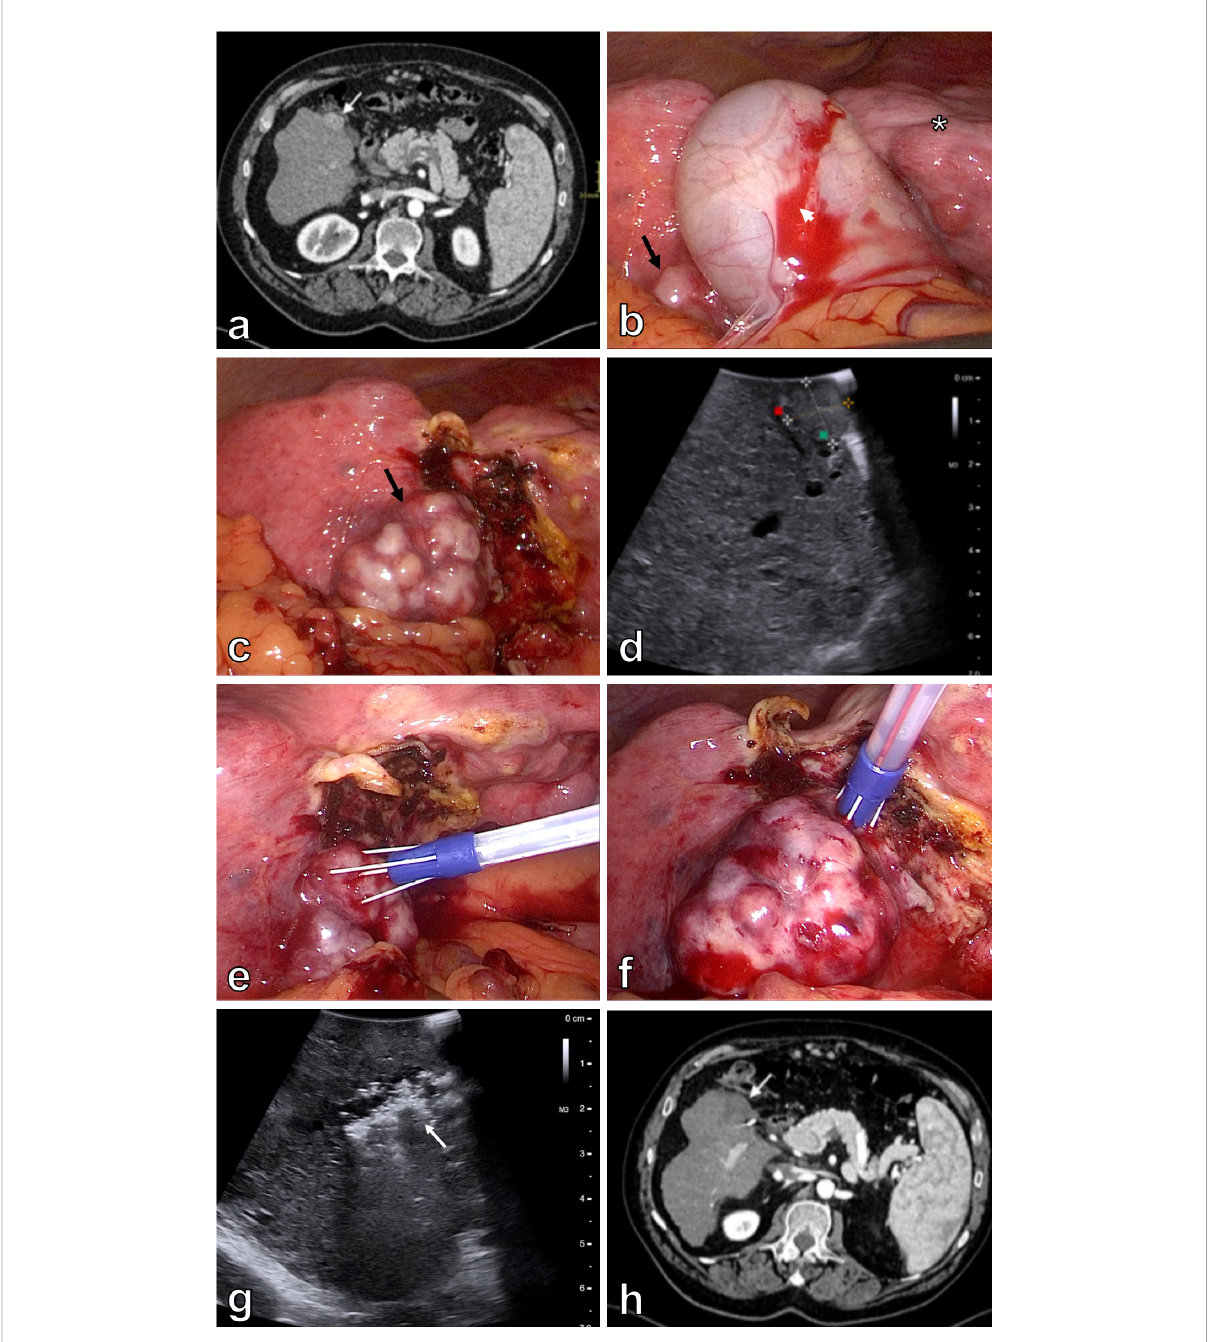
FIGURE 1 Patient 1. Initial contrast enhanced abdominal CT demonstrates a 12 x 18 mm hypervascular lesion in segment V of the cirrhotic liver (white arrow) (A) . Laparoscopy shows macronodular liver cirrhosis (asterisk) with an exulcerated tumor in segment V (black arrow). The majority of the tumor is covered with gallbladder (white arrowhead) (B) . Optimal exposure of the tumor (black arrow) is achieved after cholecystectomy (C) . Intraoperative US better demonstrates a 22 mm lesion in segment V of the liver (D) . Electric pulses are applied through 10° divergent Stinger electrode inserted in the center of the tumor (E) and around the tumor (F) . Control intraoperative US immediately after the treatment demonstrates area of avital lesion (white arrow) (G) . Contrast enhanced abdominal CT four months after the procedure demonstrates a 35 mm area of ablation necrosis in segment V of the liver (H)